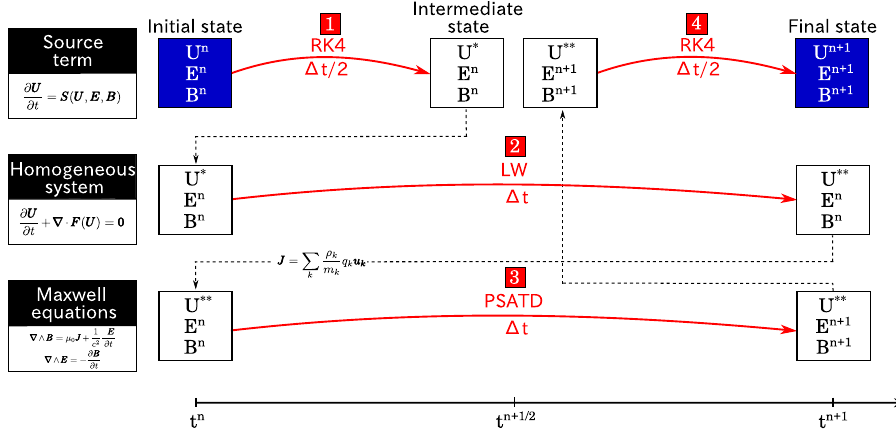
Figure 2. Schematic representation of the algorithm. The source term is integrated with an RK4 scheme while the homogeneous system is integrated with an LW scheme. Maxwell’s equations are solved with the PSATD method. The algorithm requires four steps shown in red to advance fluid variables and fields from a time step n to n + 1